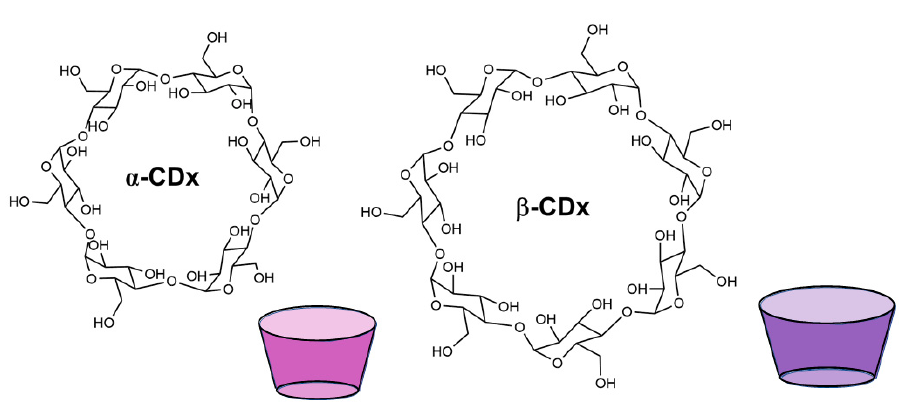
Figure 9. Structure of the receptors α -Cyclodextrin ( α -CD) and β -Cyclodextrin ( β -CD) and correscheme 41. recently synthe- sized a single substituted analogue of this macrocycle, β -CDU, with high affinity towards L -tryptophan ( K = 5.2 × 10 4 M − 1 ), thanks to the added “arm” with hydrogen bonding groups as well as a hydrophobic region (Figure 10). Despite the larger cavity of β -cyclodextrin, structural studies showed that there was no inclusion complex, contrary to what is usual for these systems, but instead the complex was formed at the entrance of the receptor. This binding was shown to happen in 2:1 host:guest stoichiometry with the receptor forming a dimer, with the analyte in the created pocket, being stabilized by hydrophobic interactions and hydrogen bonds